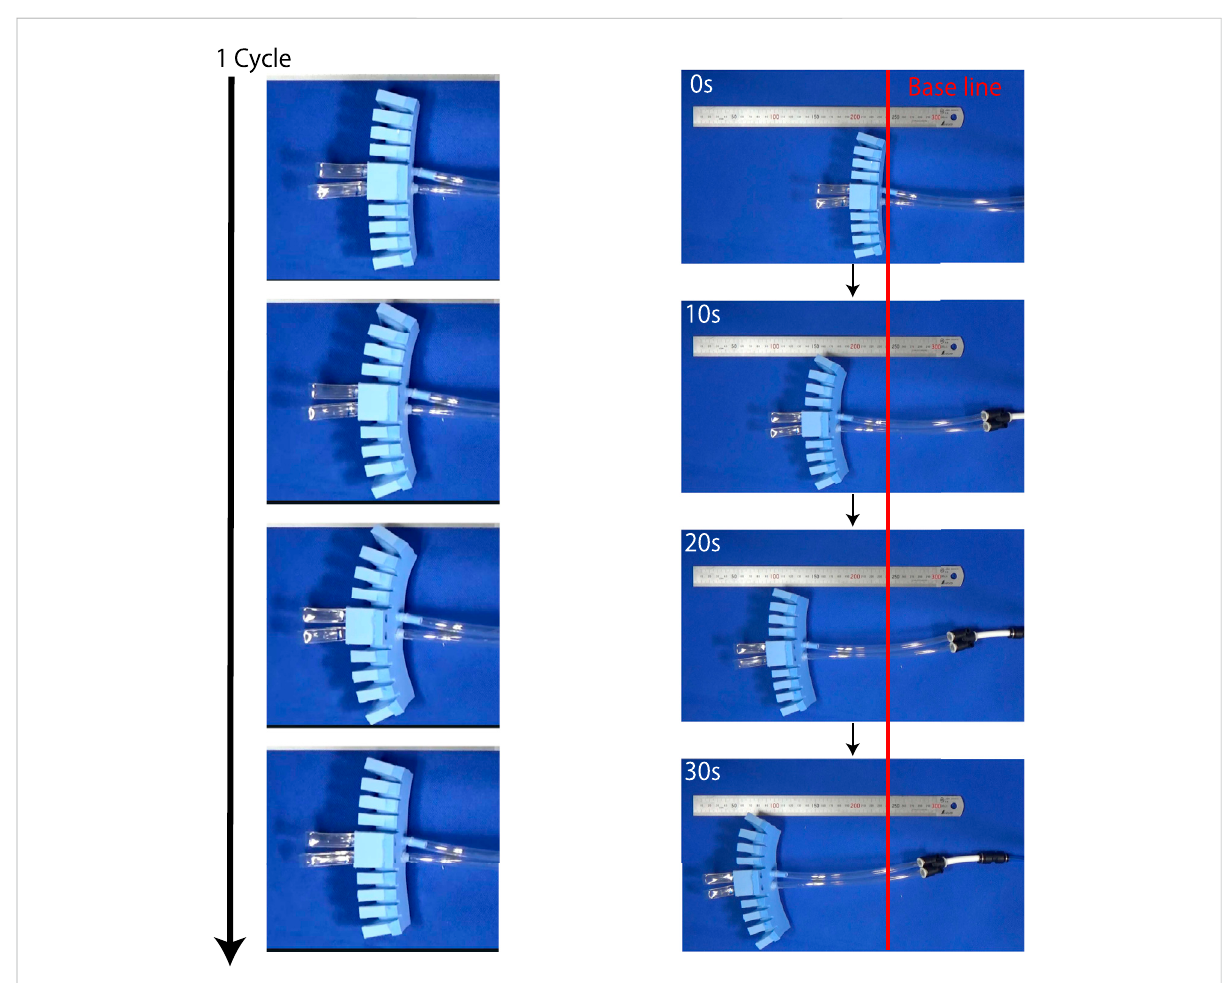
FIGURE 14 Robot walking experiment. The left fi gure shows four states of the robot in one